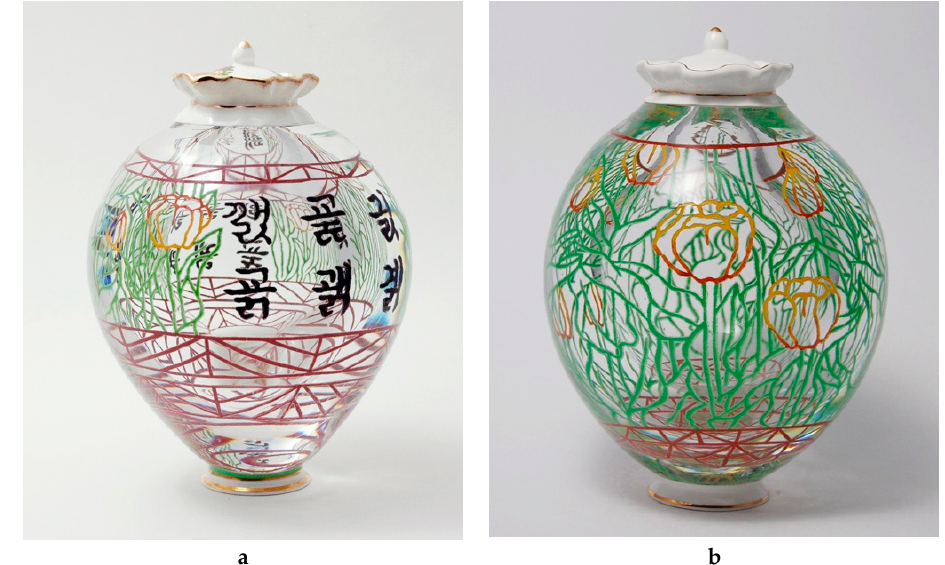
Figure 18. ( a ) ‘ Korean glass ’ 15 (2013). Cristalica glass body with Kugler glass powder: opaque red (K2124-Poppy red), opaque black (K2095-Opal black), opaque green (K2070-Opal green) and opaque yellow (K2078-Canary yellow), 260 mm (H) × 190 mm (W). ( b ) ‘ Korean glass ’ 16 (2013). Cristalica glass body with Kugler glass powder: opaque red (K2124-Poppy red), opaque green (K2070-Opal green), and opaque yellow (K2078-Canary yellow), 260 mm (H) × 190 mm (W).